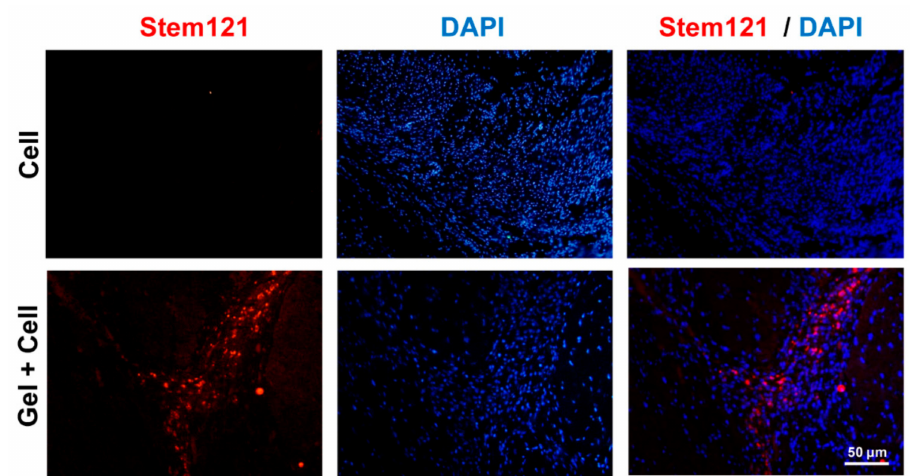
Figure 6. Cell retention after hydrogel-mediated delivery. At the fourth week, encapsulated mesenchymal stem cells (MSCs) that were injected into the myocardium were detected by immunostaining of STEM121 at the injection